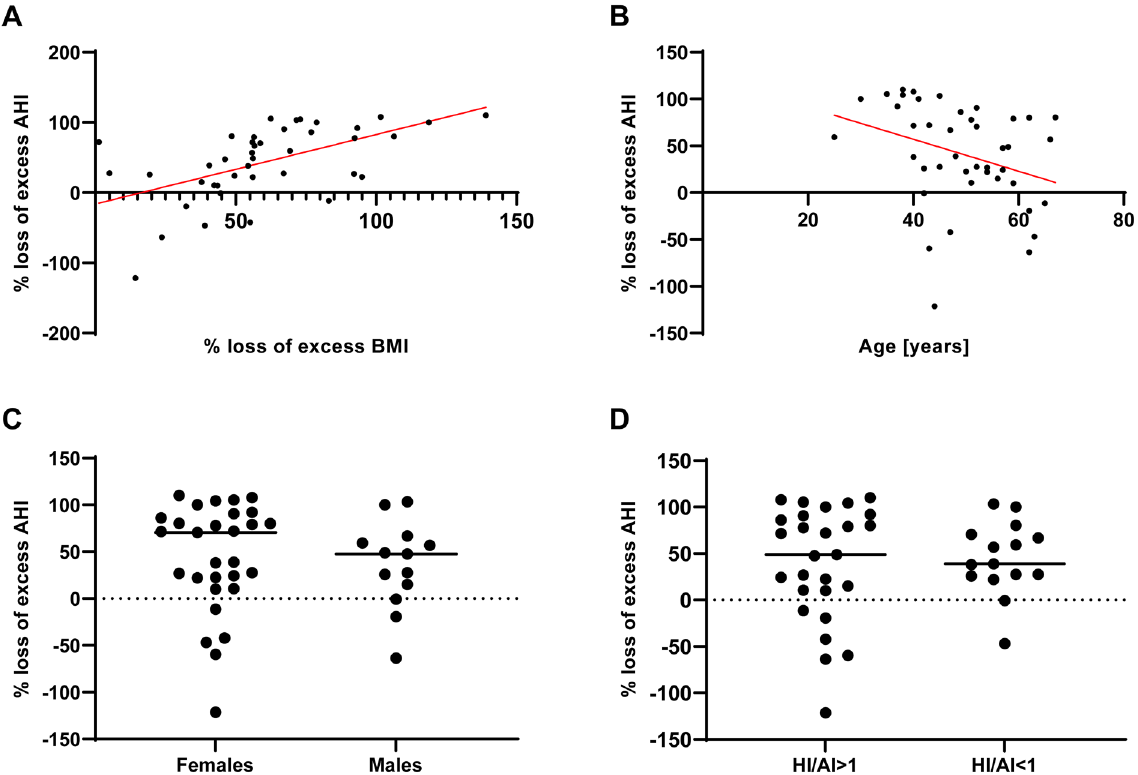
Figure 3. Percentage loss of excess AHI correlated with percentage loss of BMI ( A ), age ( B ) and compared between females and males ( C ) as well as patients with hypopnea index/apnea index ratio > 1 and < 1 ( D ). AI, apnea index; AHI, apnea–hypopnea index; BMI, body mass index; HI, hypopnea index. Red lines in A and B represent lines of best fit, while black horizontal lines in ( C and D ) represent median.